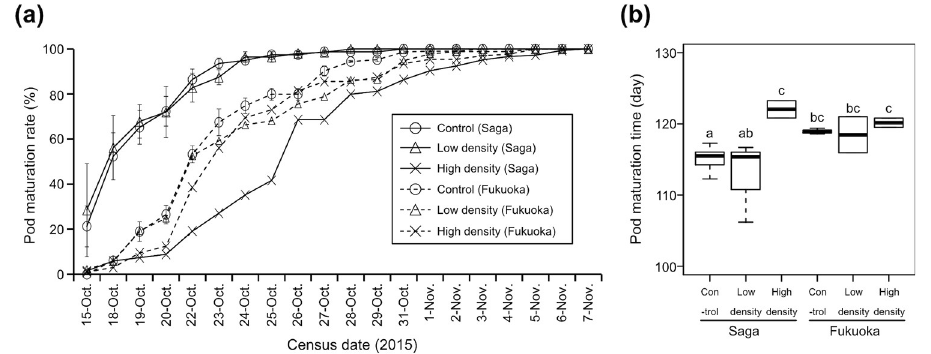
Fig 2. (a) Pod maturation rate and (b) pod maturation time of Glycine soja infested with 0 (control), 6 (low density) or 12 (high density) Riptortus pedestris females. In Fig 2A, the solid and dotted lines depict the experiment of Saga and Fukuoka strains, respectively. In Fig 2B, the different letters above bars indicate significant differences between treatments (Tukey’s HSD test; p < 0.05).